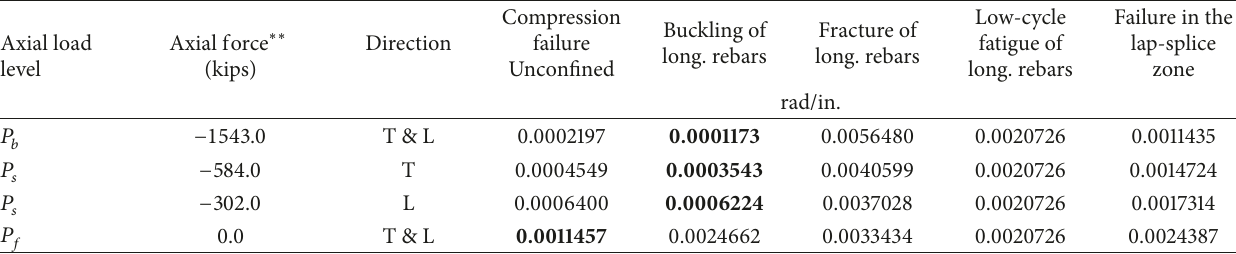
Table 6: Plastic curvature capacity of Pier #2 old columns, Bridge #1-W ∗ .